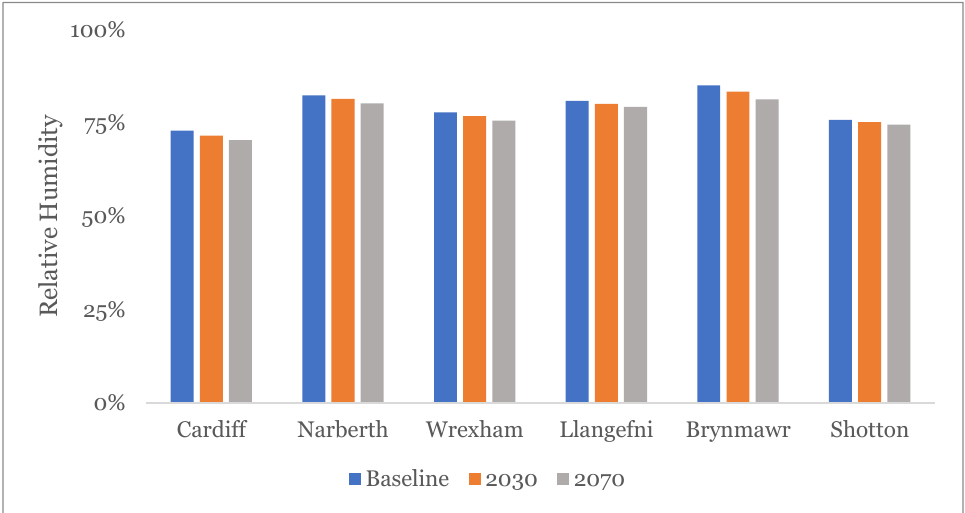
Figure 6. Daily average outdoor relative humidity for baseline, 2030 and 2070 .